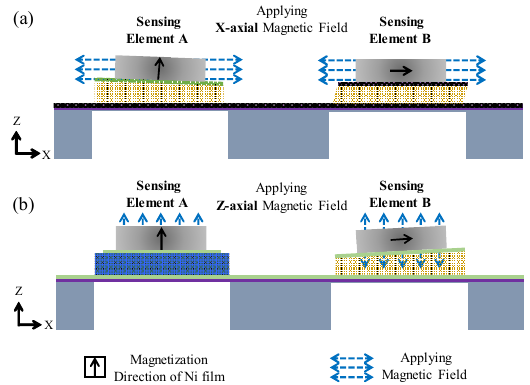
Figure 2. The magnetic field sensing principle when applying ( a ) X-axial and ( b ) Z-axial magnetic fields to the sensor, respectively. Note: the magnetization directions of the Ni thick films in sensing element A and B are Z-axial and X-axial, respectively.